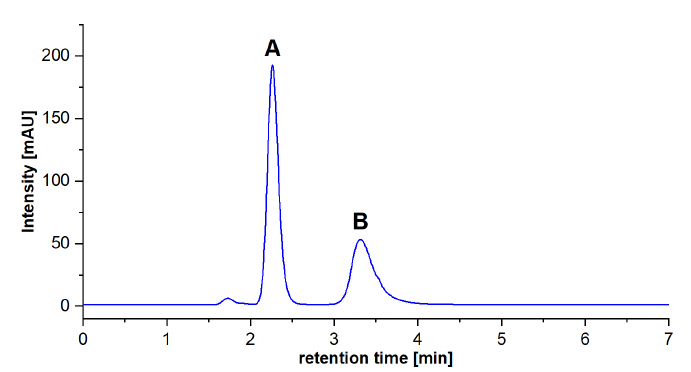
Figure 7. Separation of ( A ) TCPP (retention time 2.2 min) and ( B ) Cu-TCPP complex (retention time 3.3 min). Conditions: Phenomenex Gemini C18 column (150 mm × 4.0 mm i.d., 10 μm), mobile phase: 40:60 acetonitrile:0.05 mol L −1 CH 3 COOH/CH 3 COONa, pH 4.8, 1 mL min −1 flow rate.